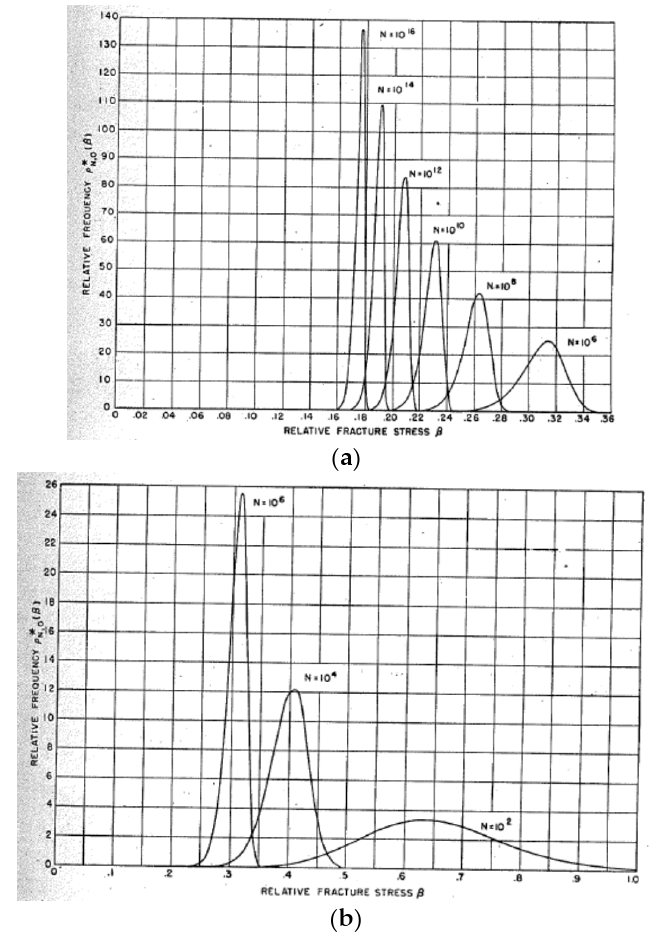
Figure 5. Theoretically predicted frequency of fracture stresses for specimens containing N microcracks. ( a ) The range of N is from 10 6 to 10 16 . ( b ) The range of N is from 10 2 to 10 6 . Reprinted with permission from Ref. [119]. Copyright 1947, the Minerals, Metals & Materials Society.